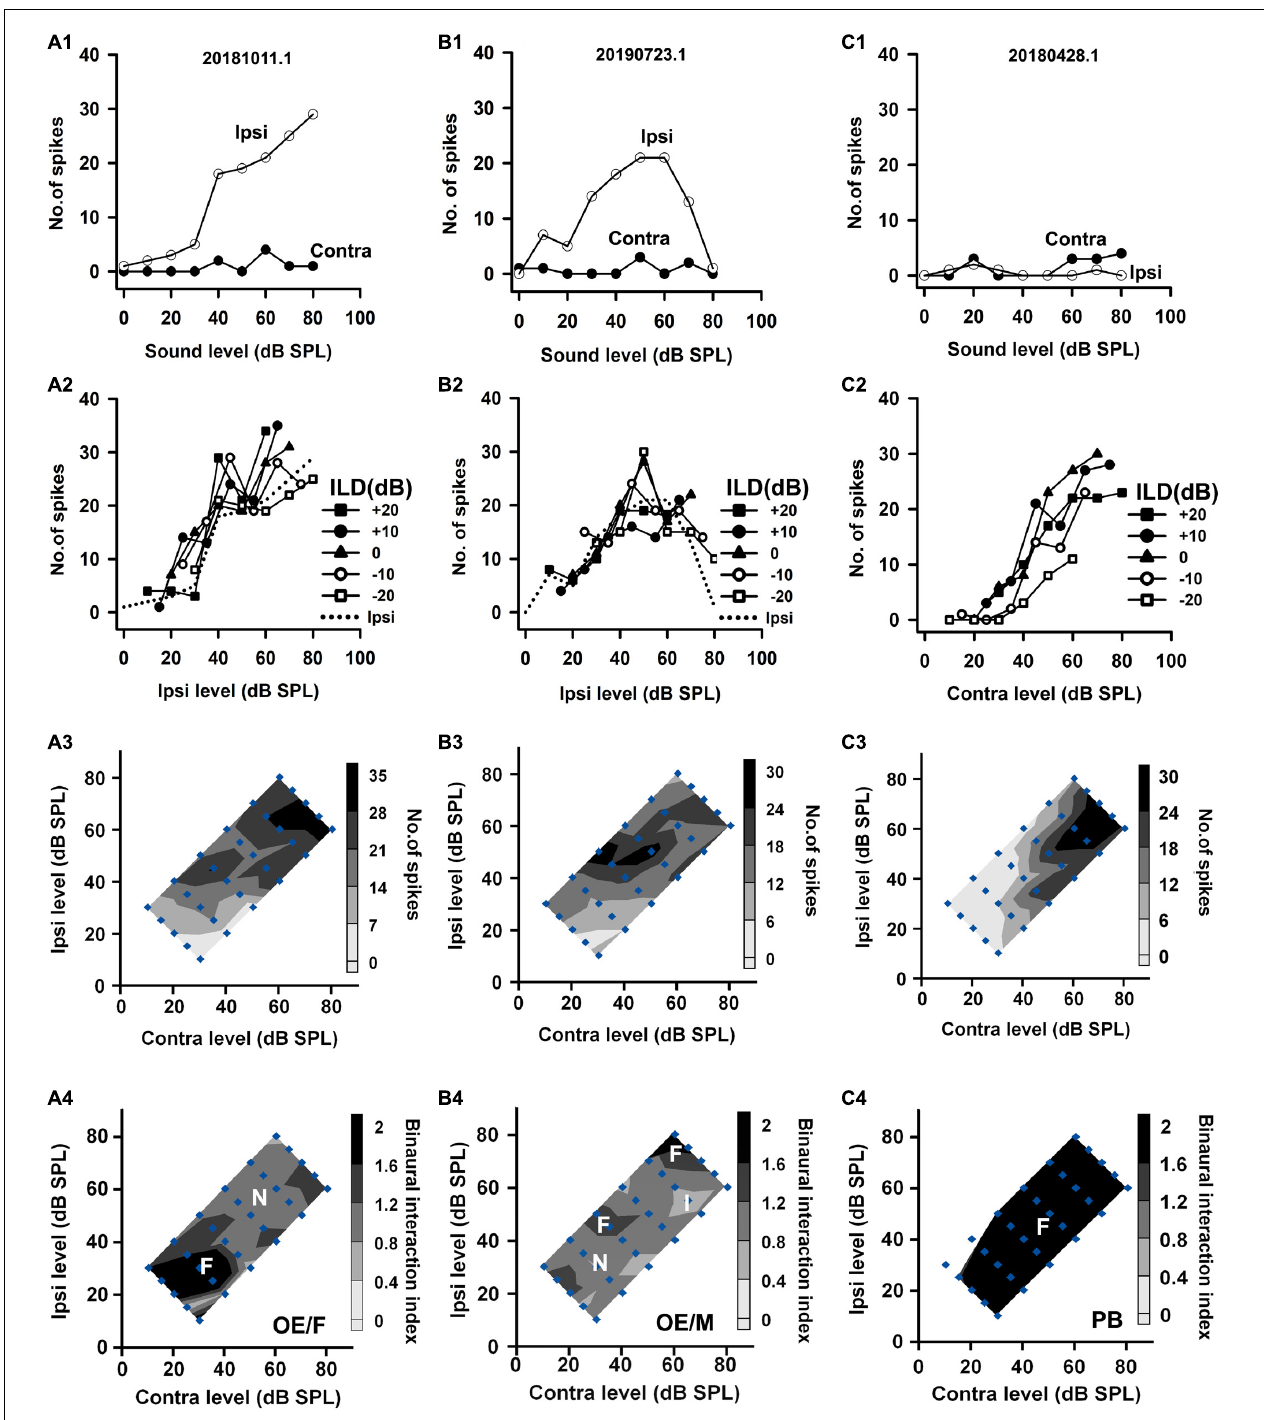
FIGURE 4 | The responses of two OE neurons and one PB neuron to both monaural stimuli and binaural stimuli. The data shown in each column are from one neuron. The legends for the four rows are similar to those in Figure 2 . The three neurons were categorized as OE/F, OE/M, and PB, respectively.